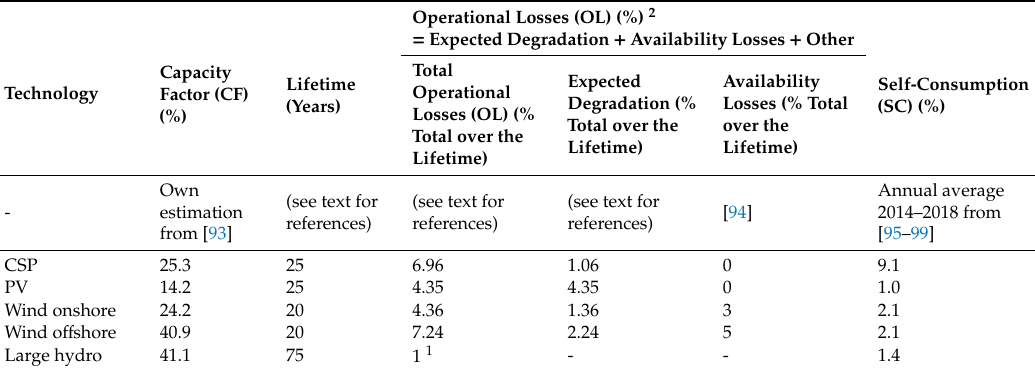
Table 2. Performance factors considered in this study per technology. The capacity factors have been estimated from IRENA database [93] from the reported electricity production in 2015 and the average power between this year and the previous year to reduce the error due to the high annual capacity growth. See references in text and supplementary